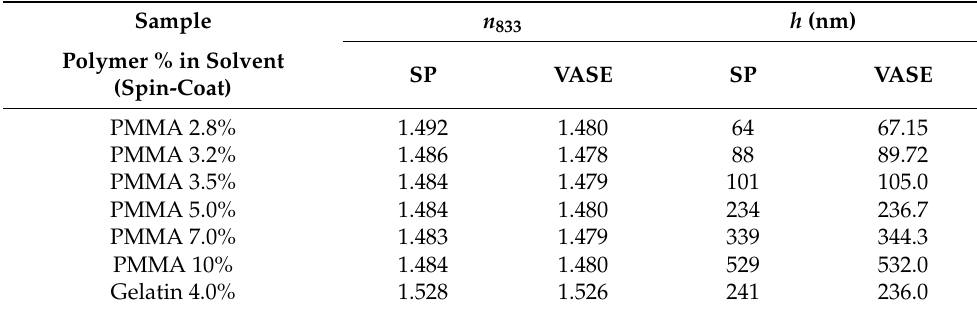
Table 3. Comparison of n and h of PMMA and gelatin films, obtained with the proposed spectropho- tometric method (SP) and with